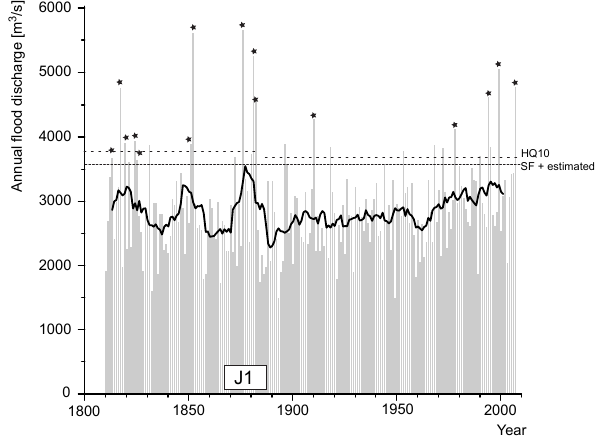
Fig. 2. Annual flood series of the Rhine river in Basel between 1808 and 2007 (grey bars) and its 11-year running mean (black line). Years with recorded flood damage are marked with stars. Horizontal lines correspond to the thresholds estimated with different methods defining a significant flood (SF = same frequency method). The HQ10 discharge was estimated separately for the time before and after the first Jura water correction (J1). Data from FOEN (2007) and Ghezzi